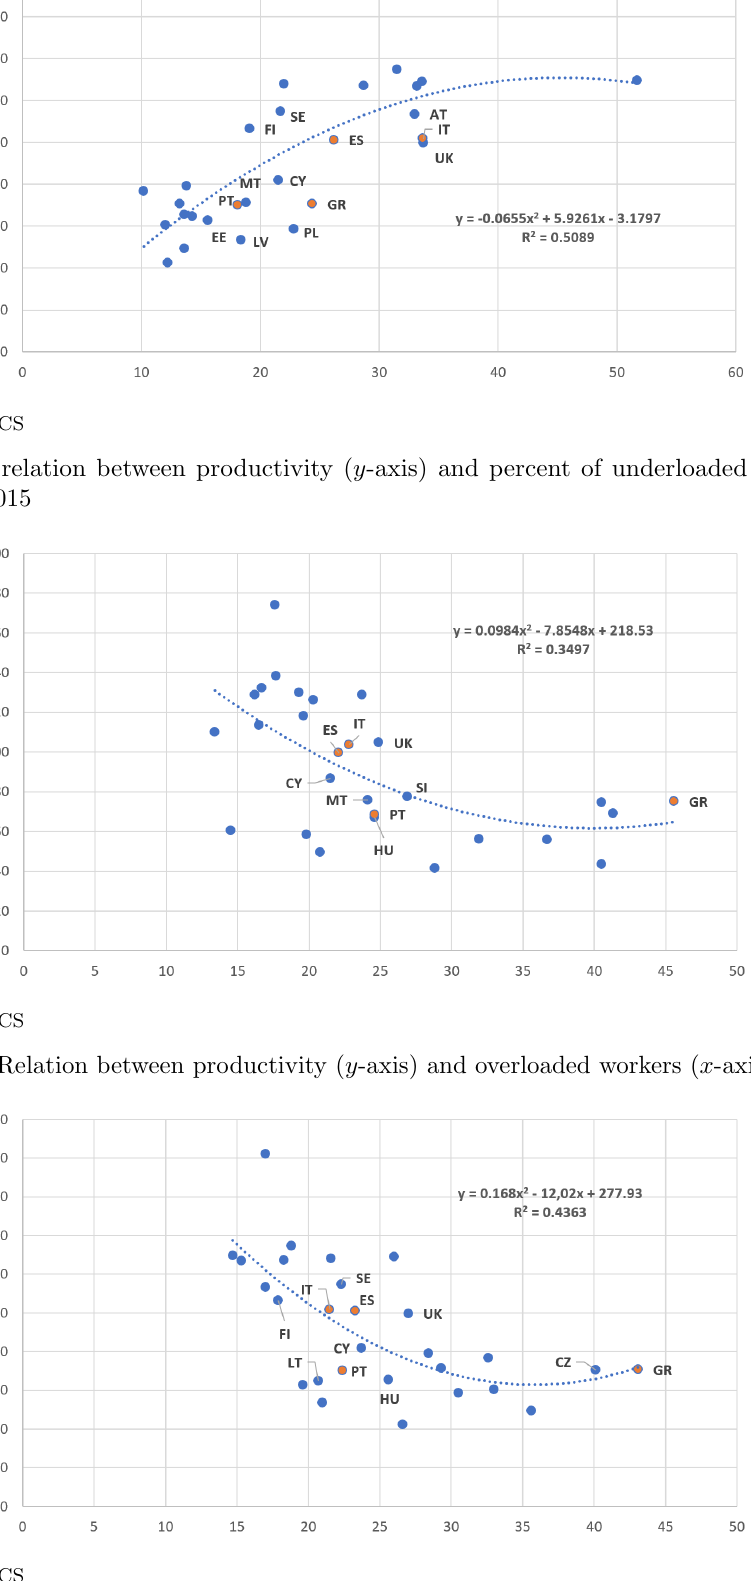
REGION : Volume 5, Number 3,